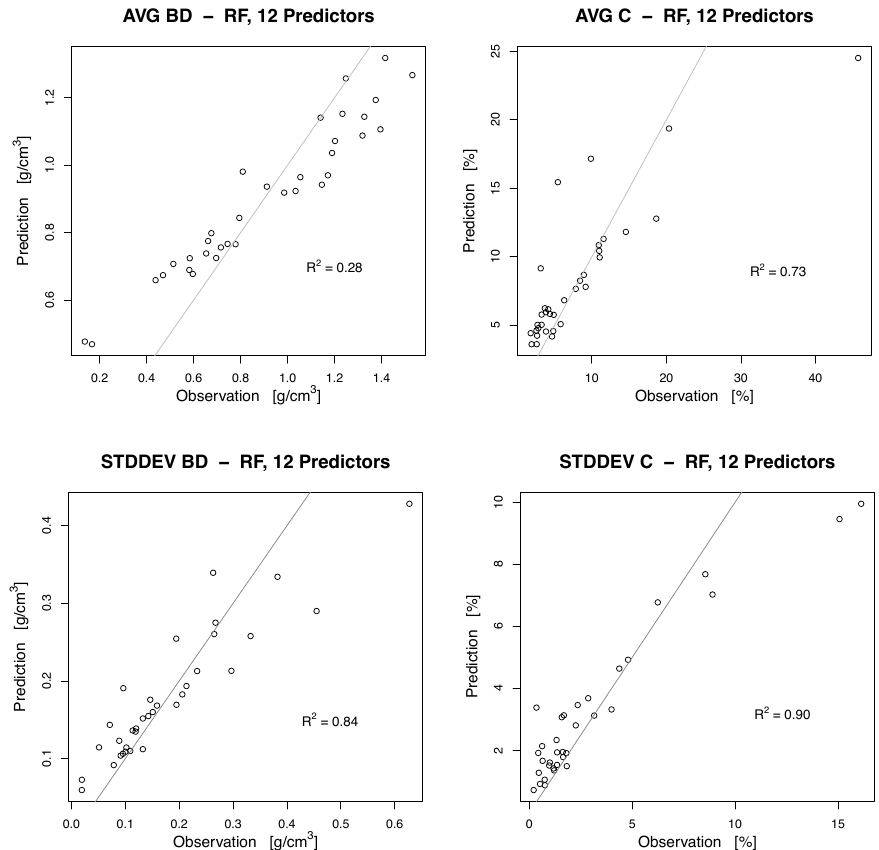
Figure 4. Accuracy plots for AVG BD, AVG C, STDDEV BD and STDDEV C for the 0-15 cm depth layer for the respective RF models corresponding to 12 predictors (see Table 2).